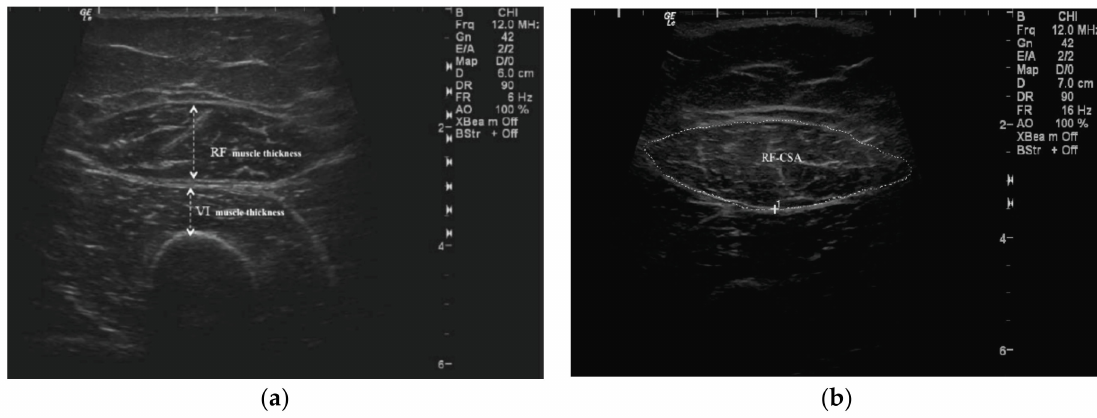
Figure 2. Quadriceps muscle thickness (QMT) and cross-sectional area (CSA): ( a ) QMT of rectus femoris (RF) and vastus intermedius (VI) muscles; ( b ) RF